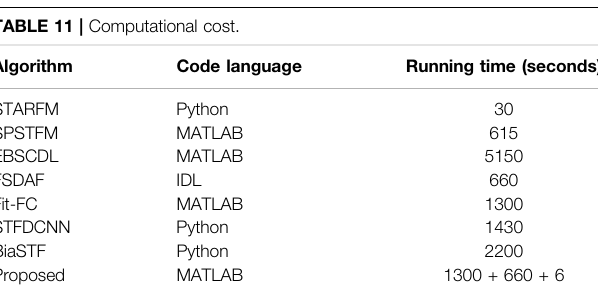
TABLE 11 | Computational